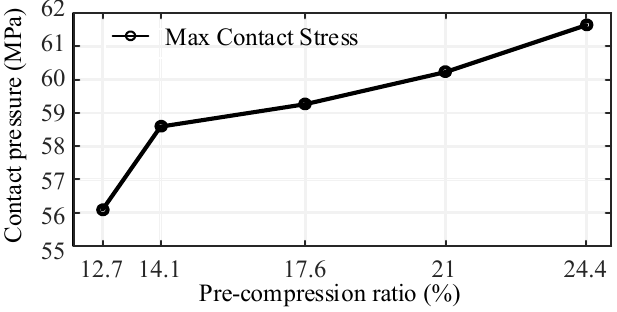
Figure 19. Contact pressure affected by compression ratio.